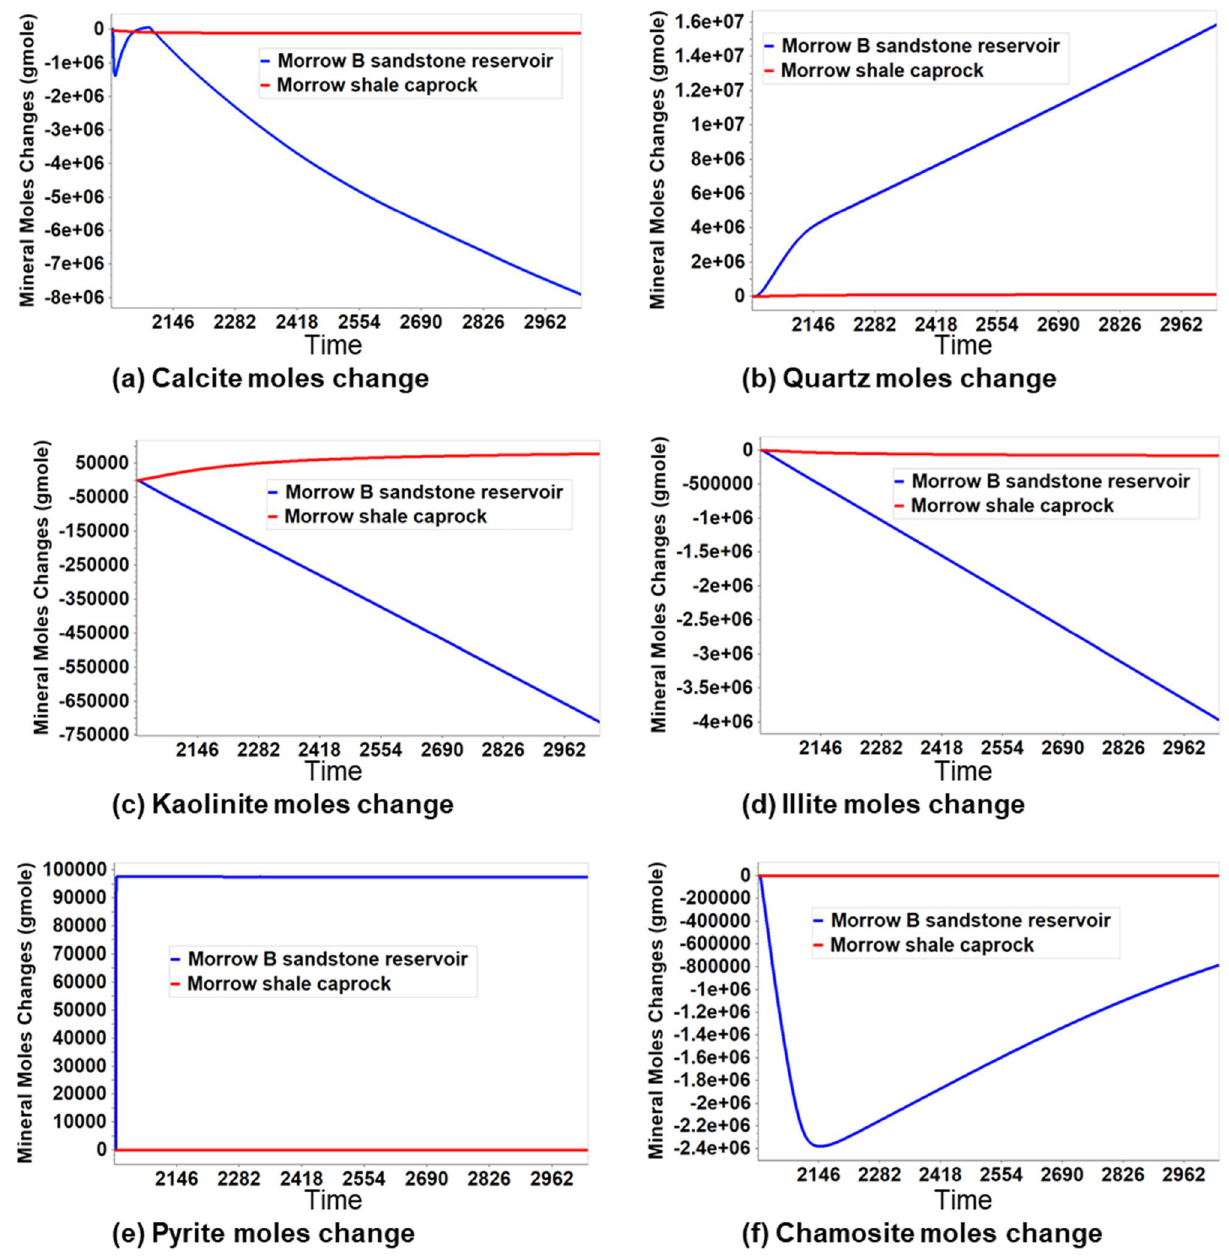
Figure 7. The evolution of dissolution and precipitation of minerals in the reservoir and the caprocks during 1000 years of post-injection